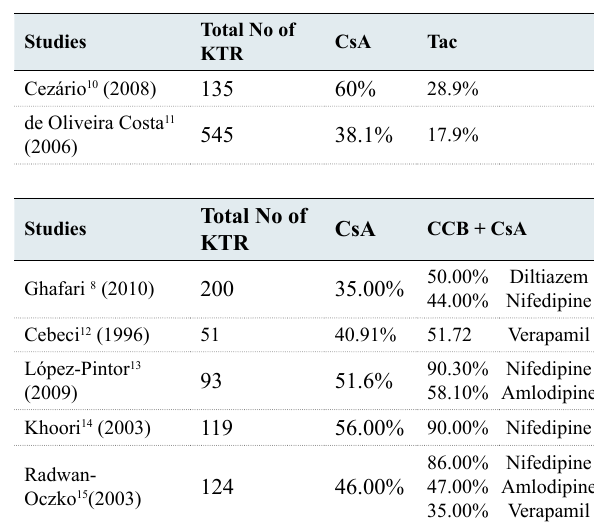
Table 3: Prevalence of Gingival Overgrowth in Kidney